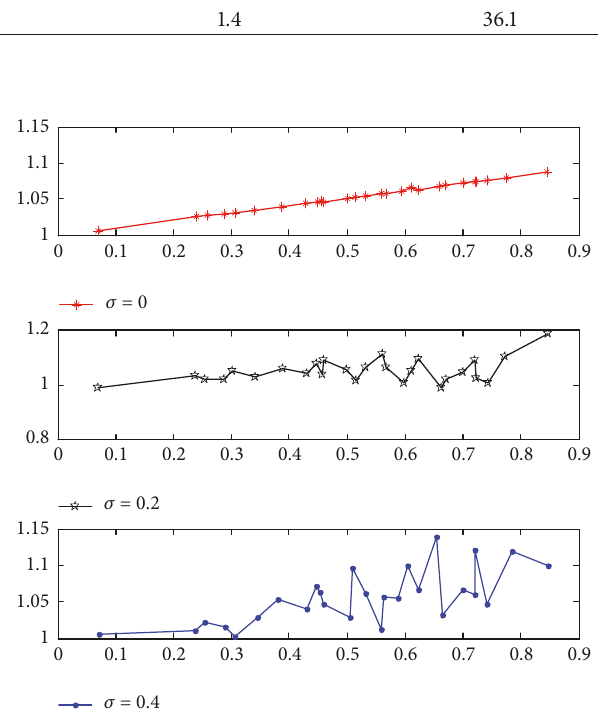
Figure 7: The inversion result of the thermal conductivity.